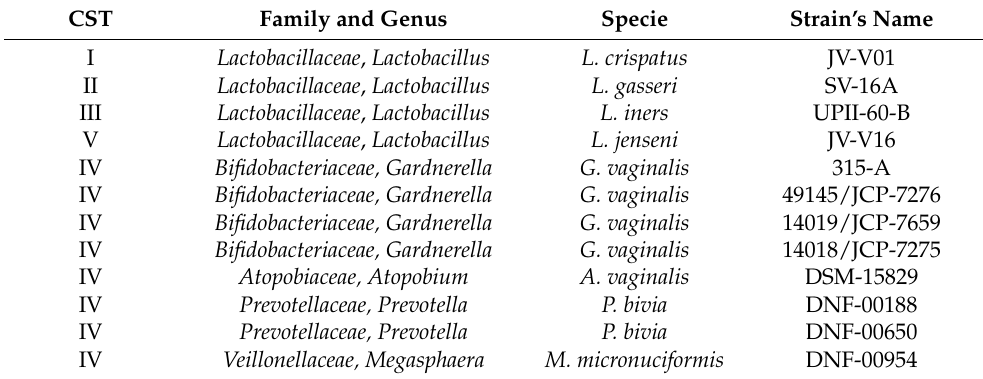
Table 1. Reference bacterial